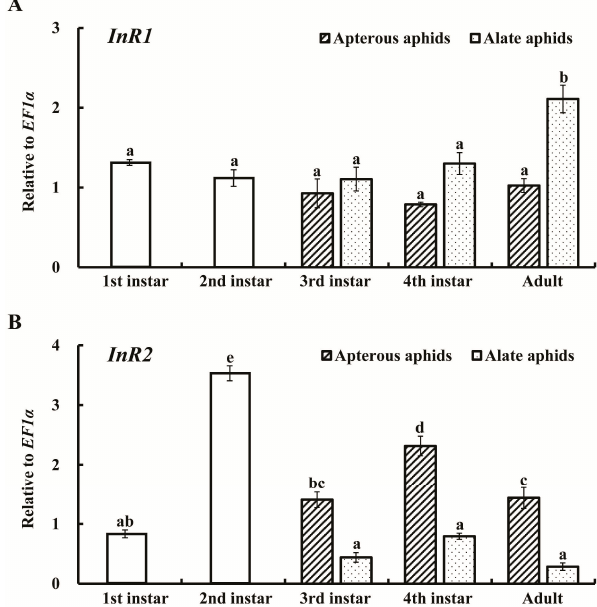
Figure 2. Expression profiles of AcInR1 ( A ); and AcInR2 ( B ) at different developmental stages of Aphis (Toxoptera) citricidus . The mean (±SE) expression level is based on four biological replicates. Different lowercase letters (a, b, c, d, e) above each bar indicate significant differences among different developmental stages and wing morphs using one-way ANOVA followed by Tukey’s honestly significant difference (HSD) multiple comparison test ( p < 0.05).